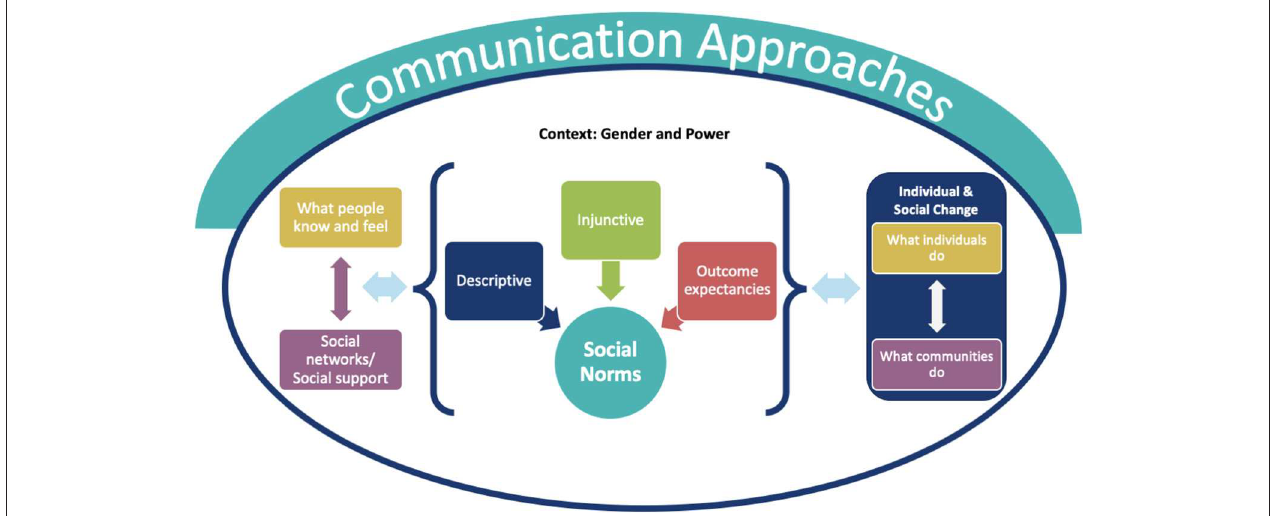
FIGURE 1 | Conceptual model for ACT